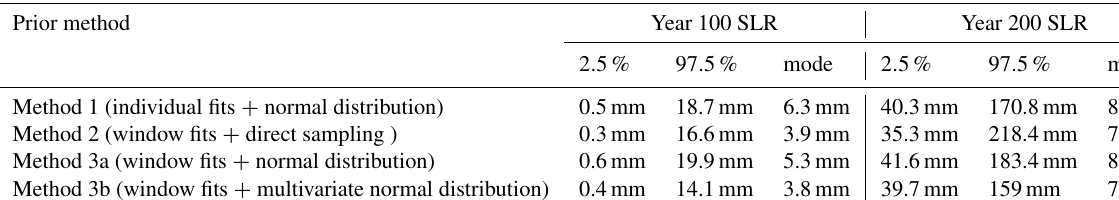
Table 2. Emulated sea level rise prediction statistics for three prior methodologies.